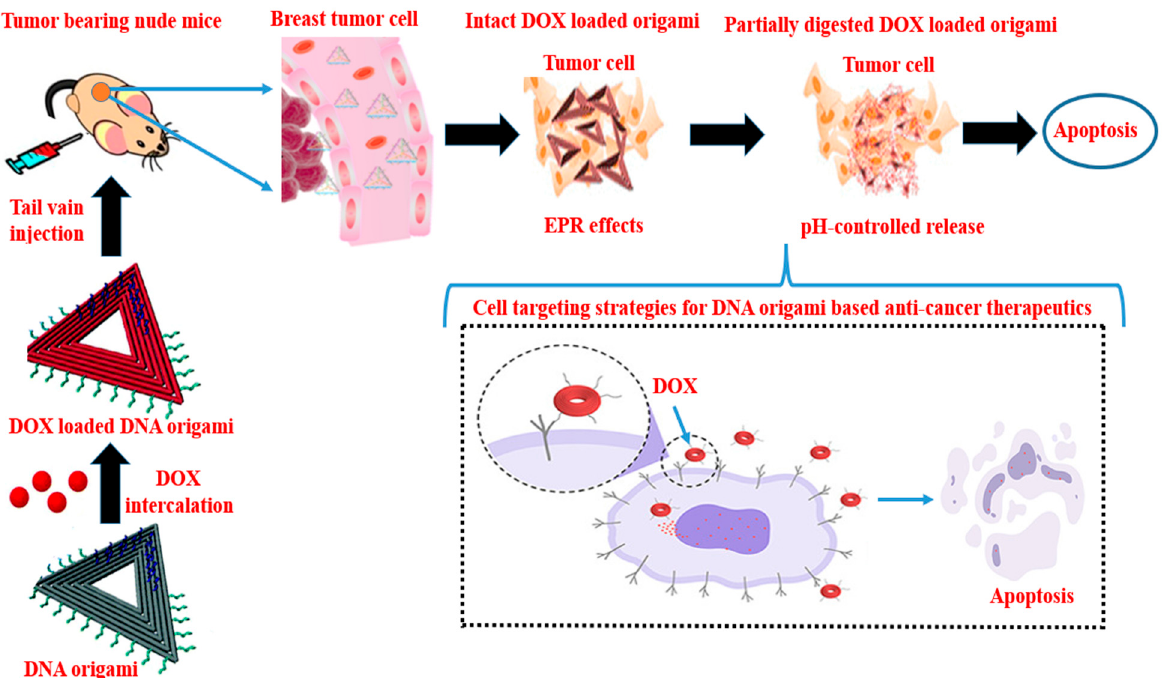
Figure 2. DOX loaded distribution of triangular origami and pH-controlled release in vivo, revealing strong passive DOX accumulation in cancerous regions and overall excellent therapeutic benefits in vivo.